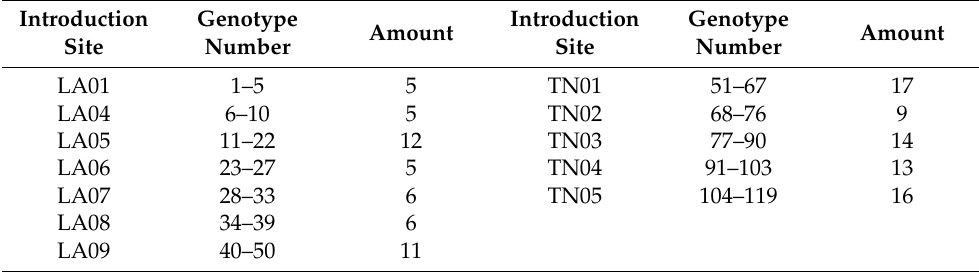
Table 2. Genetic background. Numbers 1–50 are from Louisiana (LA) provenance, and numbers 51–119 are from Tennessee (TN) provenance. The samples used were all clones; they were all cuttings directly imported from the United States. The numbers after LA and TN do not represent the half-sib relationship and are only used to distinguish the